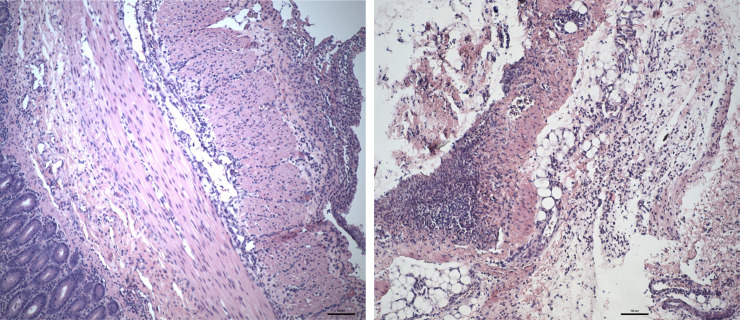
Histology of intestine and mesenterium.4A The mucosa is down at left and the serosa is at right. The serosa shows a rich fibrinopurulent exudate, consistent with peritonitis. Leukocytes between the smooth muscle layers also are visible (AF-16). 4B Mesenterium. Necrosis and intense inflammatory reaction in the fat and connective tissues, consistent with peritonitis (control).